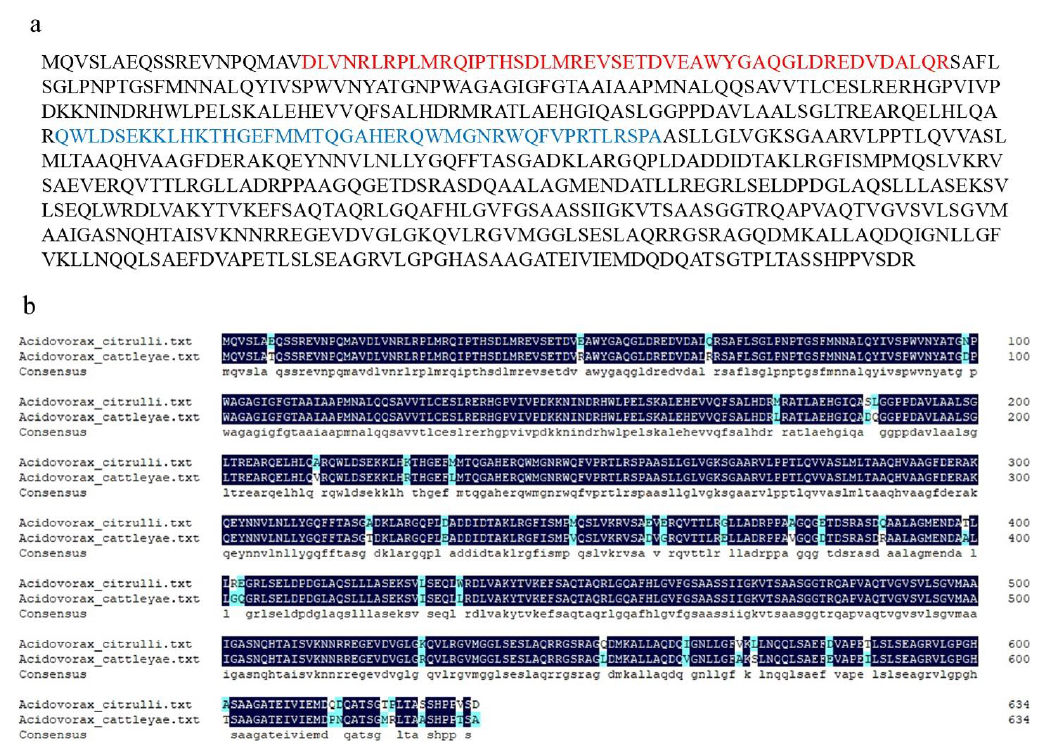
Figure 1. Sequence analysis of AopN from Acidovorax citrulli . ( a ) Amino acid sequence of AopN contained motifs DUF4129 (marked in red) and Cpta_toxin (marked in blue). ( b ) Pairwise sequence alignment of AopN with its homolog from A. cattleyae (WP_092832167).